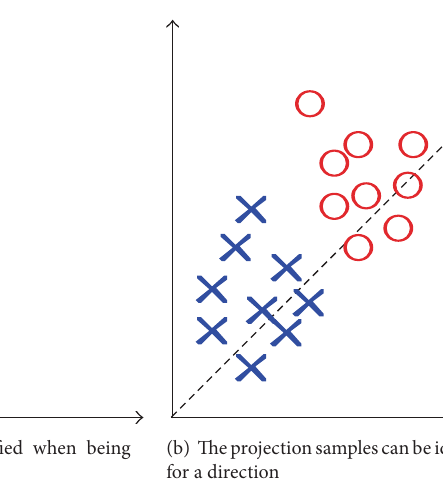
Figure 4: Schematic diagram of Fisher linear discriminant